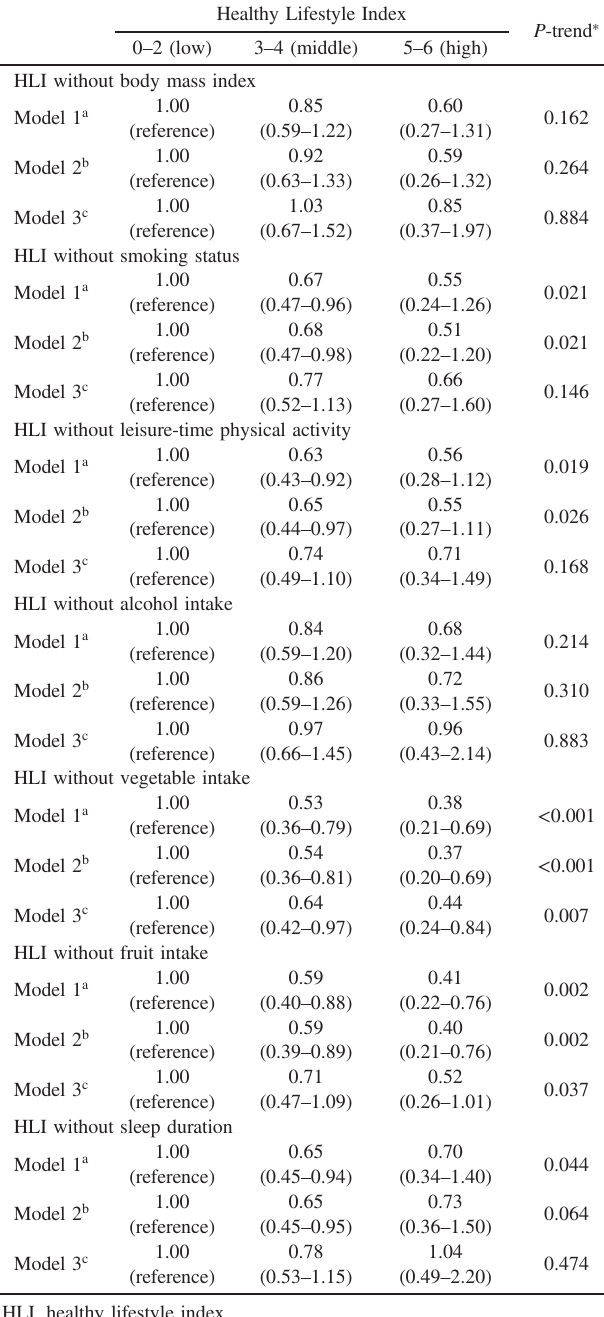
Table 3. Odds ratios and 95% con fi dence intervals of depressive symptoms according to the Healthy Lifestyle Index